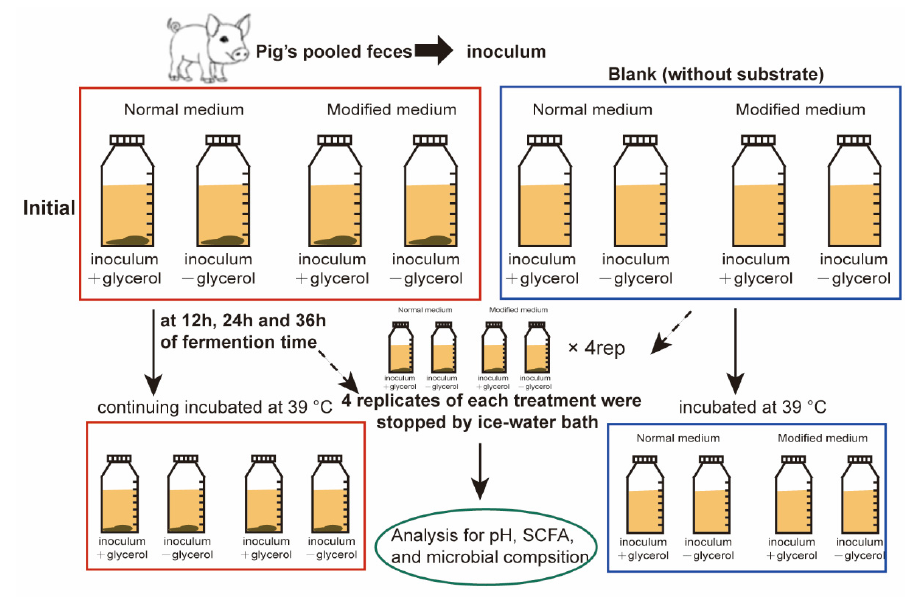
Figure 1. Study Figure 1. Study design.